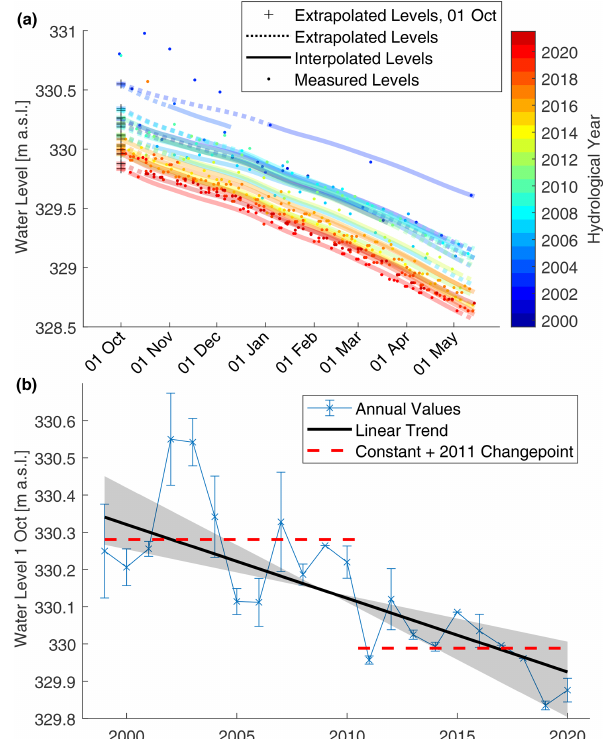
Figure 10. (a) Dry-season water levels for each hydrological year from 2000–2021. The crosses indicate the extrapolated WSH on 1 October, which is used as a proxy for the floor level at the outflow. Values above 330.4ma.s.l. are considered outliers and are not con- sidered for extrapolation. (b) Time series of extrapolated WSH on 1 October. Error bars represent the range of values obtained by con- sidering the uncertainty in the rates used for extrapolation (Fig. 7). The transparent area indicates the 95% CI of the linear regression slope. The dotted red line shows an alternative interpretation of the data, speculating that a single strong erosive event in 2011 may have lowered the outflow level by approximately